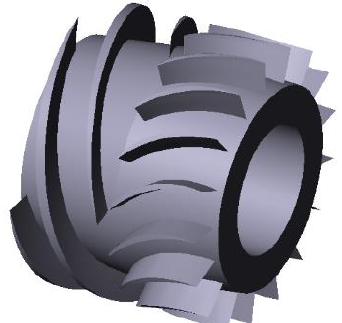
Figure 1. The model of the impeller and diffuser.